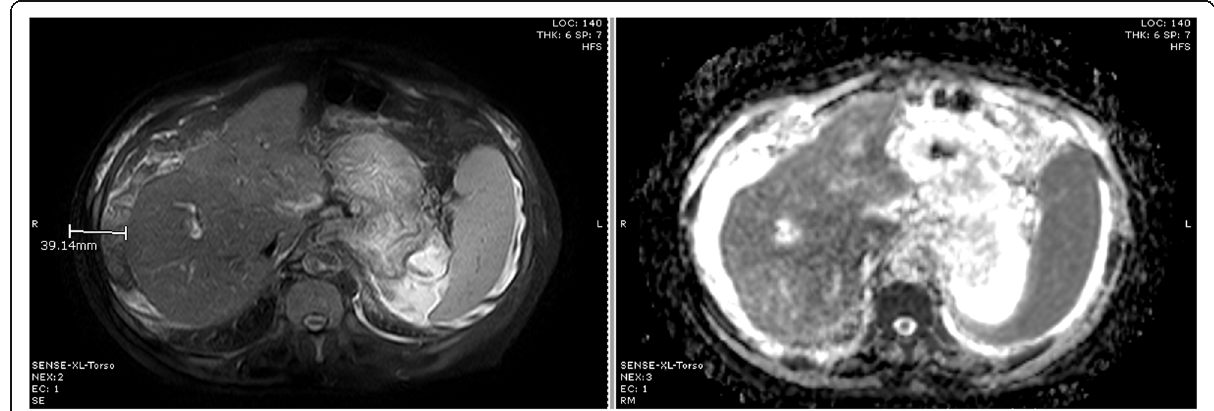
Fig. 8 Excluded case as there was moderate amount of ascites, it was classified as F4 by Fibroscan while mean liver ADC value =1.5 and mean spleen ADC=1.07 and